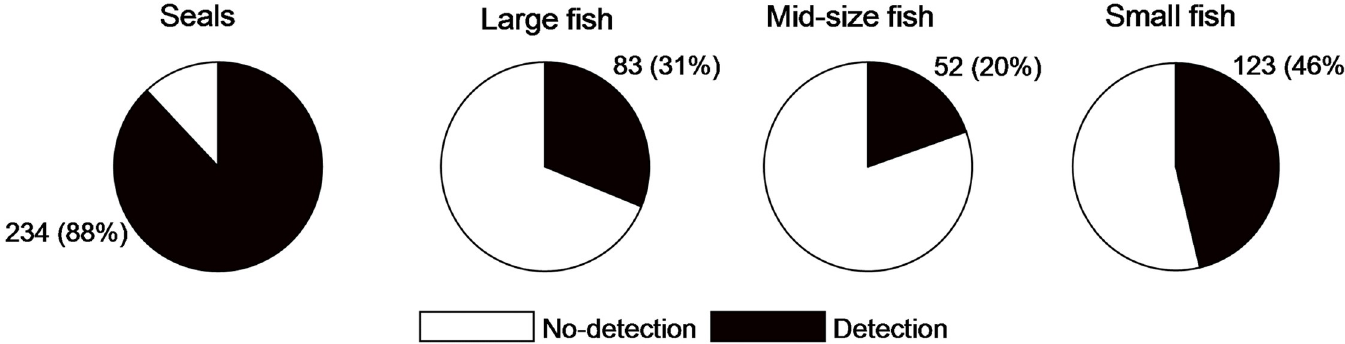
Fig 6. Total number of observations versus number of observations that resulted in target detection. For example, on a total of 260 observations 234 contained seals, and 32 did not contain seals.